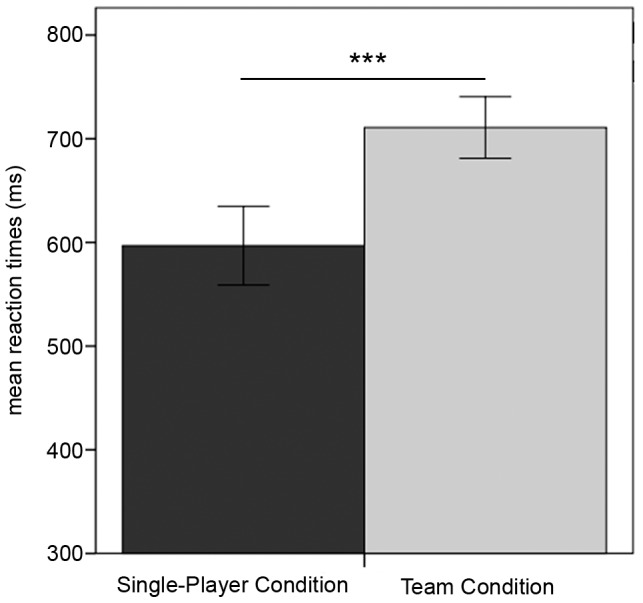
Reaction Times.Mean reaction times for choice period for single-player and team condition. Error bars represent one standard error. ***Indicates significant difference between conditions at p<0.001.